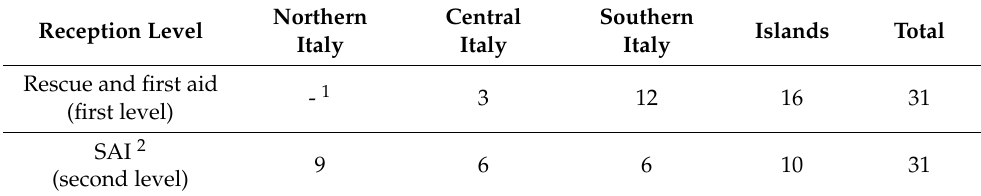
Table 1. Distribution of the interviews with respect to the level of reception and territorial area. Reception Level